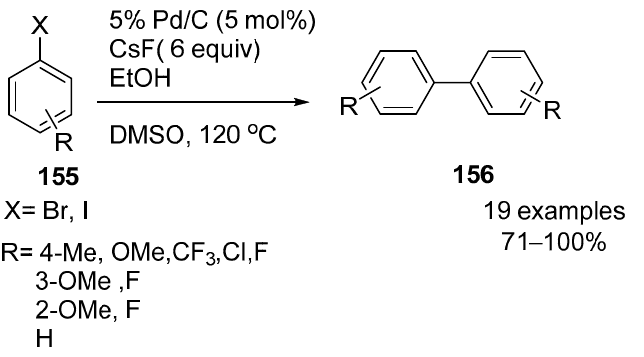
152 Scheme 30. Synthesis of styrylphosphonate derivatives via Pd/C reduction. Sajiki’s group studied the Pd/C-catalyzed homocoupling of terminal alkynes 153 to produce 1,2-diynes 154 , which is known as the Glaser coupling reaction (Scheme 31) [79]. Previous researchers studied the effect of copper catalysts and homogeneous palladium- copper catalysts on the homocoupling process [62]. Sajiki and co-workers worked on het- erogeneous Pd/C-catalyzed protocol. Subsequent optimization work showed that only 0.01 mol% of 1%Pd/C was required with the support of 3 mol% CuI in DMSO as a solvent. Using this strategy, a variety of diyne derivatives 154 could be prepared in good to excel- lent yields. Scheme 31. Synthesis of diyne derivatives via Pd/C catalysis. Qi’s group disclosed a Pd/C-catalyzed ethanol-promoted Ullmann-type